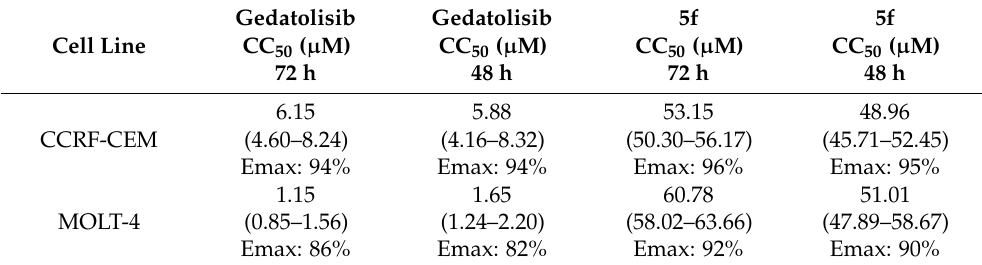
Table 5. CC 50 values calculated using the Muse ® Count & Viability Kit on CCRF-CEM and MOLT-4 after 72 and 48 h of